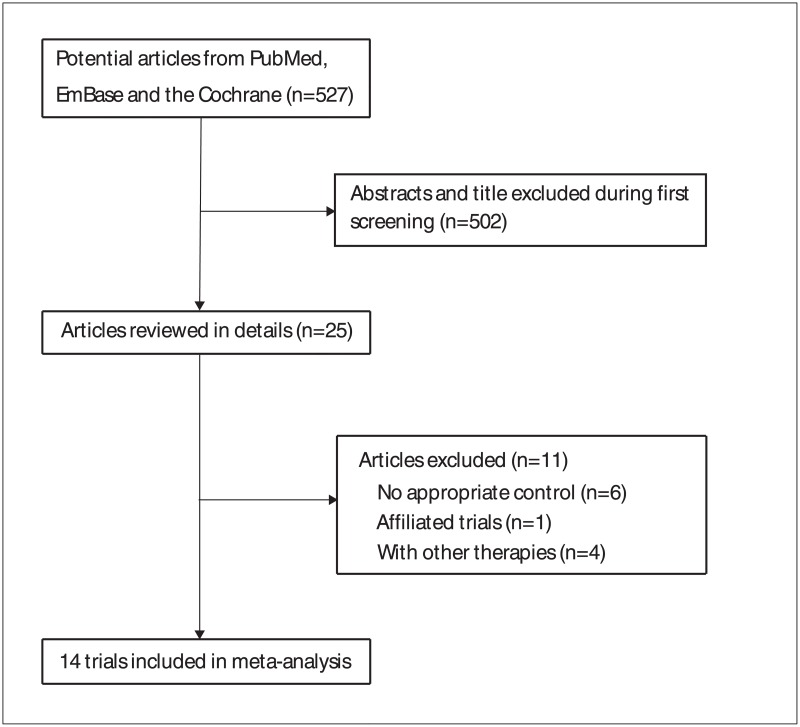
Study selection process.